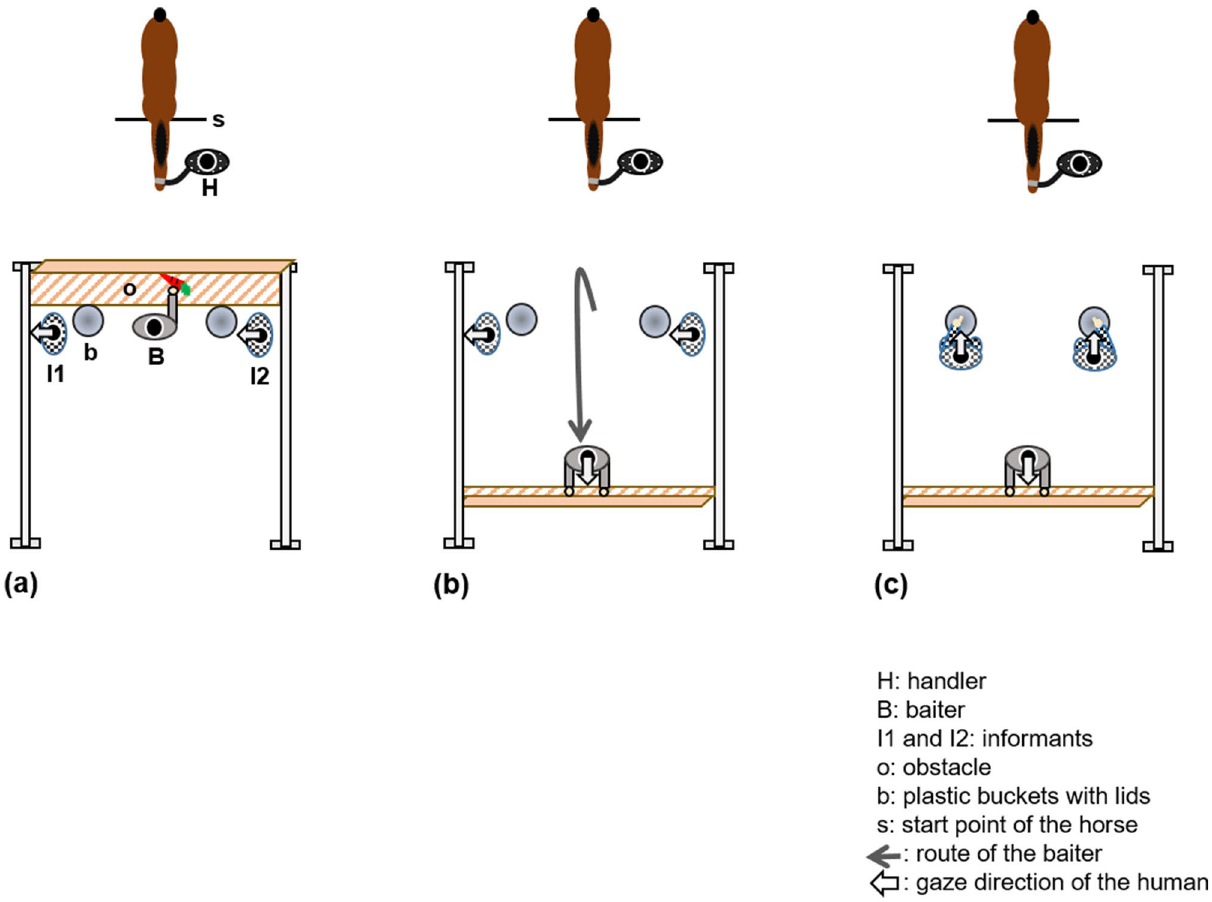
Figure 3. Schematic representation of the test trial. ( a ) When the baiter shows the carrot to the horse. ( b ) When the baiter removes the obstacle and goes into the middle and behind the informants. ( c ) When the two informants go behind the buckets and make choices by pointing at each bucket. Here, I1 acts as a guesser and I2 acts as a The second step was conducted “with the obstacle” to hide the buckets, and the apparatus was identical to that in the test trial. First, the baiter set the obstacle and hid the buckets from the horse’s view. The handler then came to a predetermined place with the horse. The latter procedure was identical to that in the first step (without the obstacle), except for making a sound with the lid of both buckets when closing them and removing the obstacle before the baiter said “Go!”. We intentionally made the closing lid sound to make it difficult for the horses to recognise which bucket was baited and to keep attracting the horse’s interest in this set-up. If the horse made a correct choice (i.e., chose the bucket pointed at by the baiter) in three consecutive trials or four out of five trials, the horse proceeded to the test trial. Test. A horse and all four female experimenters (handler, baiter, and two informants) participated in the test trials. The two informants were unfamiliar with the horses prior to the experiment. The informants appeared at the set-up after the cue from the baiter, which was just before the test trial began. After they arrived, they were positioned to predetermined places looking in the same direction with different visual access to the buckets and the baiter (faced/faced away) (Fig. 2). Then, the handler who was blind to the role of the informants came to the start point with the horse and stayed still looking down, so as not to affect the choice of the horse. The baiter showed a whole carrot to the horse and said “Ninjin, ireruyô” in Japanese, meaning “I’ll put the carrot in”. The baiter opened both the buckets placed behind the obstacle and pretended to place the carrot inside the bucket (the carrot was hidden in the front bag of the baiter, the inside of which was invisible), and closed both the buck- ets, making a sound with the lids (Fig. 3a). While baiting, the horse was unable to observe any of the movements of the baiter that were lower than her chest, because of the obstacle. Then, the baiter stood up, lifted the obstacle, and turned to go to the middle, behind the informants (Fig. 3b). After the baiter said “Go!”, the informants turned using two steps and chose one of the buckets (i.e. crouched down behind one of the buckets and pointed to the lid of each bucket) with the same timing. The informants used their outside hands to point to the bucket lids while holding their inside hands behind their backs (Fig. 3c), to clearly show their choices to the horse. Immediately after the informants started pointing, the baiter said “Go!” for the second time, and the handler released the rope of the horse and allowed the horse to move freely to make a choice. The informants continued